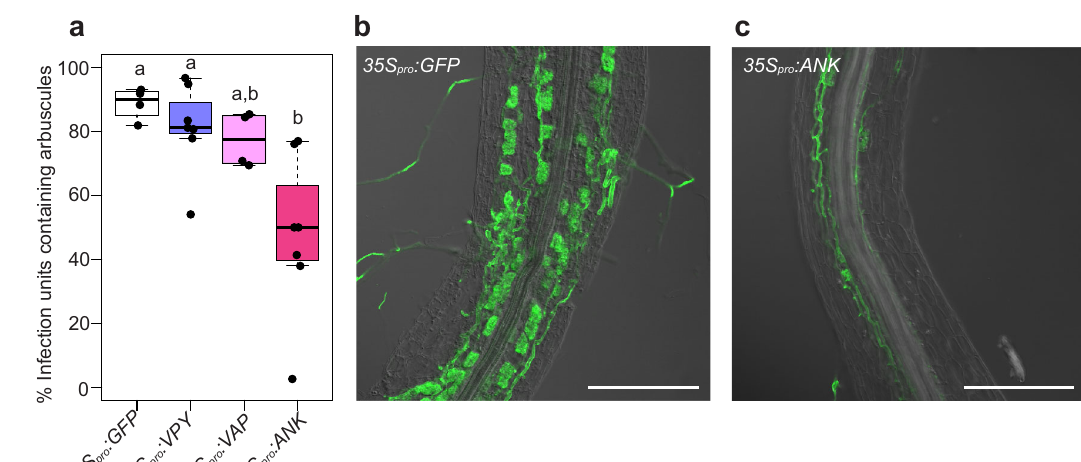
Fig. 5 | Overexpressing the ankyrin repeat domain (ANK)in WTplantsreduces arbuscule abundance. WT roots were transformed with 35S pro :VPY ( n =7 root systems), 35S pro : VAP ( n =4 root systems), 35S pro :ANK ( n =7 root systems), or a negative control construct, 35S pro :GFP ( n =4 root systems) and colonized with D. epigeae . a Percentage of infection units containing arbuscules in transgenic roots. Different letters indicate statisticallysigni fi cantdifferences using one-way ANOVA,